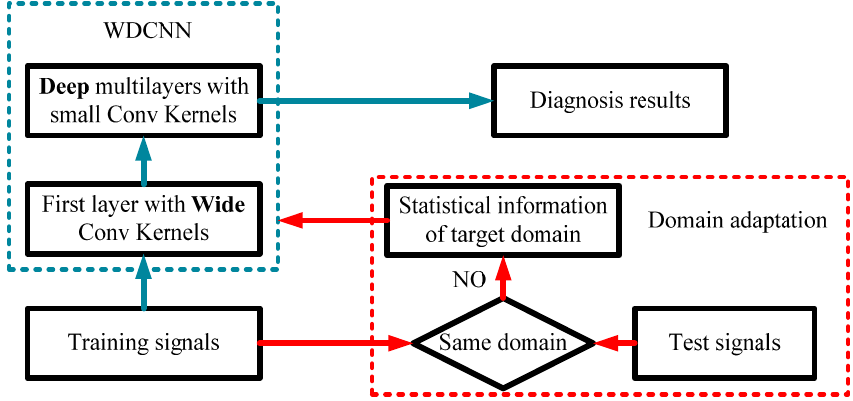
Figure 2. The overall framework of proposed WDCNN with AdaBN domain adaptation.